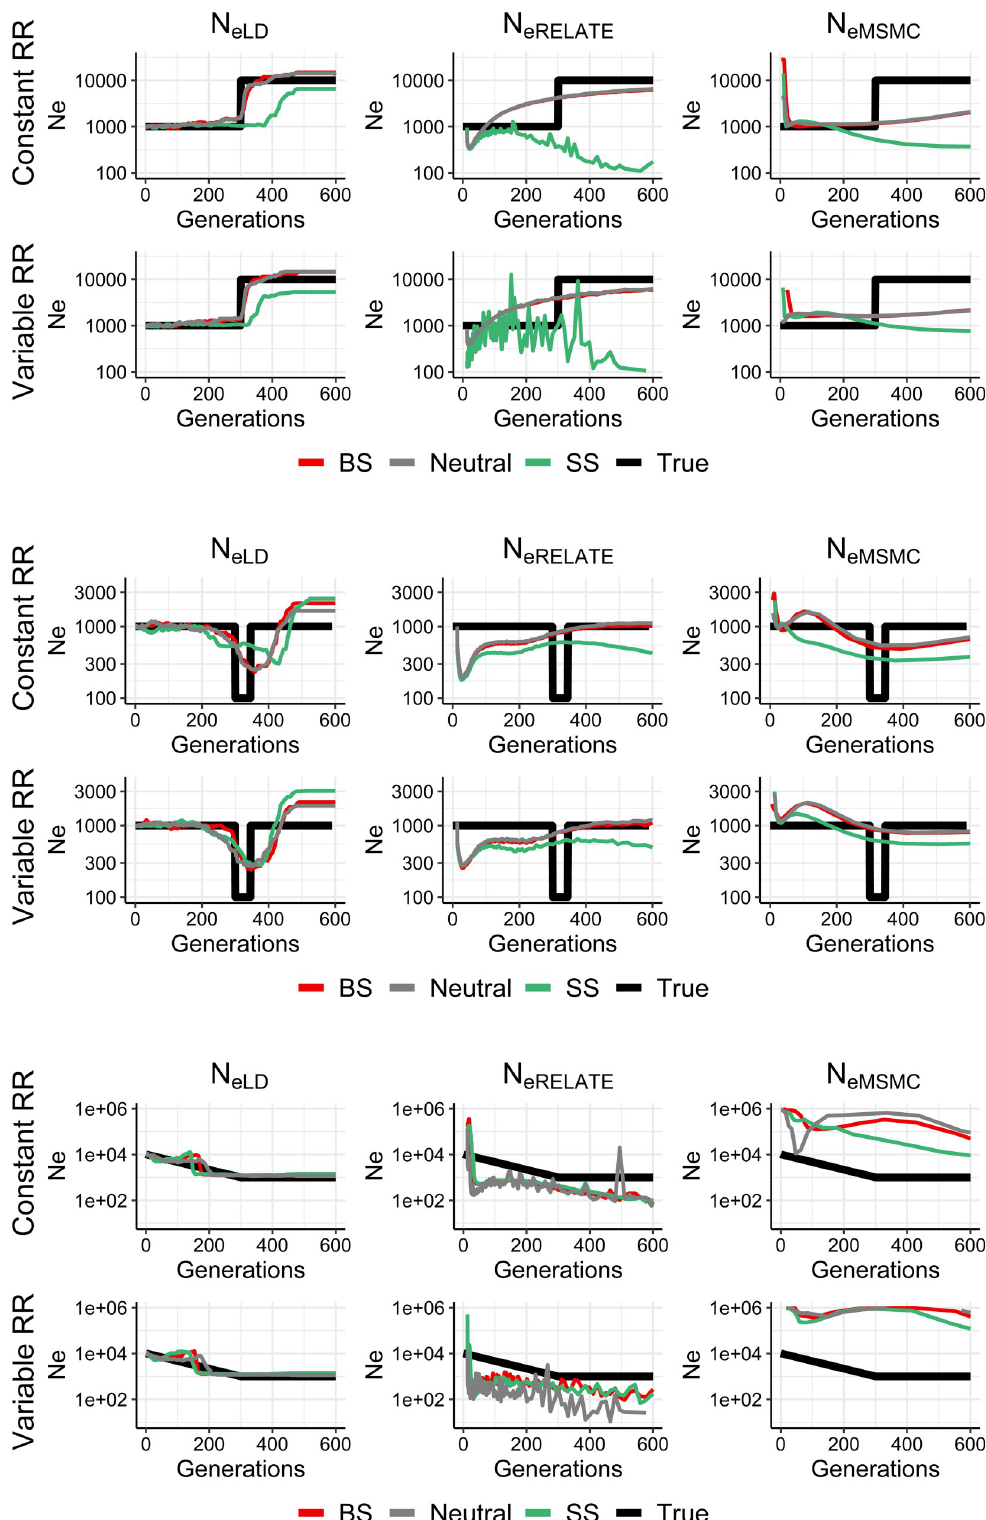
Fig 4. Estimates of historical effective population size from linkage disequilibrium ( N eLD , sample size n = 100 individuals), Relate ( N , n = 100) and MSMC ( N , n = 4) from the present generation (generation 0) back eRelate eMSMC